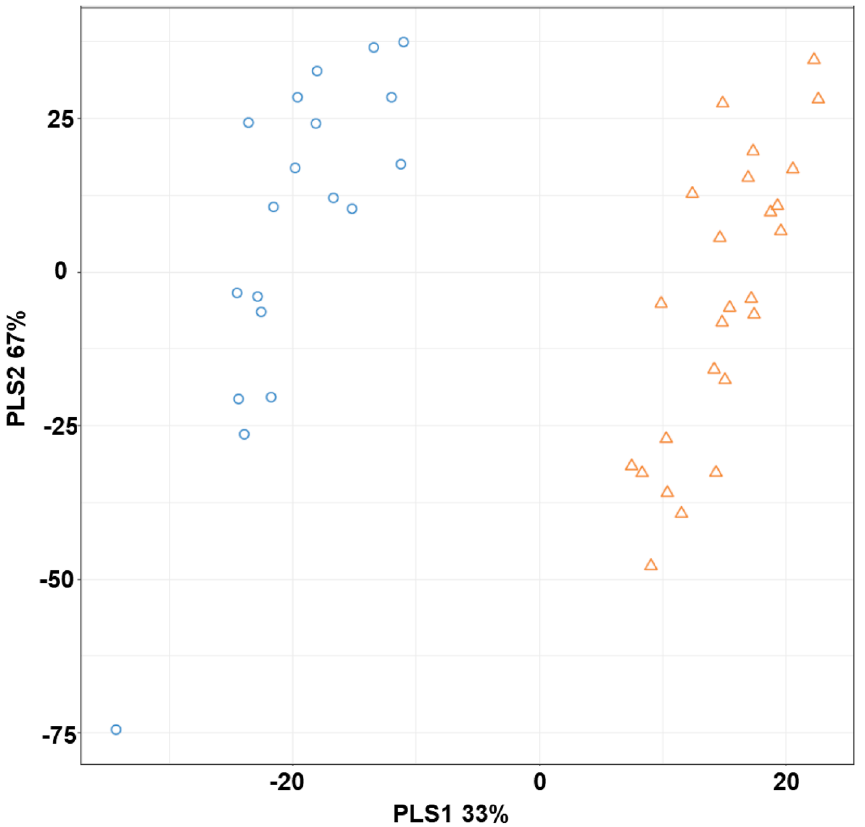
Figure 2. OPLS-DA plot using the m/z results of the significant metabolites with VIP > 2. Blue = Rejection, Orange = No rejection. Component 1 on the x-axis represents 33% of the significant features; while Component 2 on the y-axis represents 67% of the